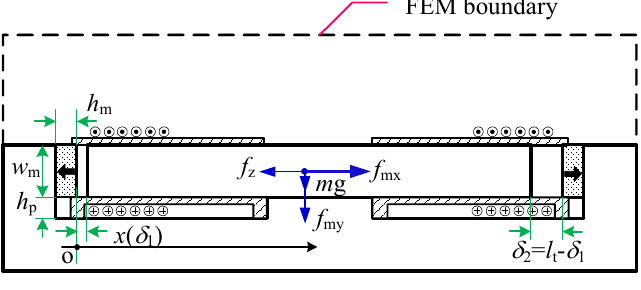
Figure 2. 2D analysis model of the